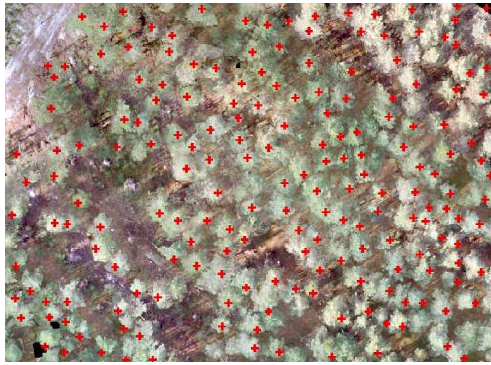
Figure 3. The applied method of local maxima seeds for the derivation of tree heights (red crosses show the detected treetops by the local maxima approach).